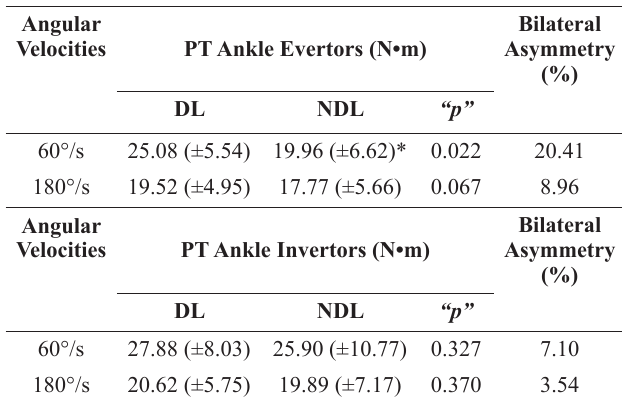
Table 1. Mean and standard deviation values for peak torque of the evertors and invertors of the dominant limb and the non-dominant limb’s